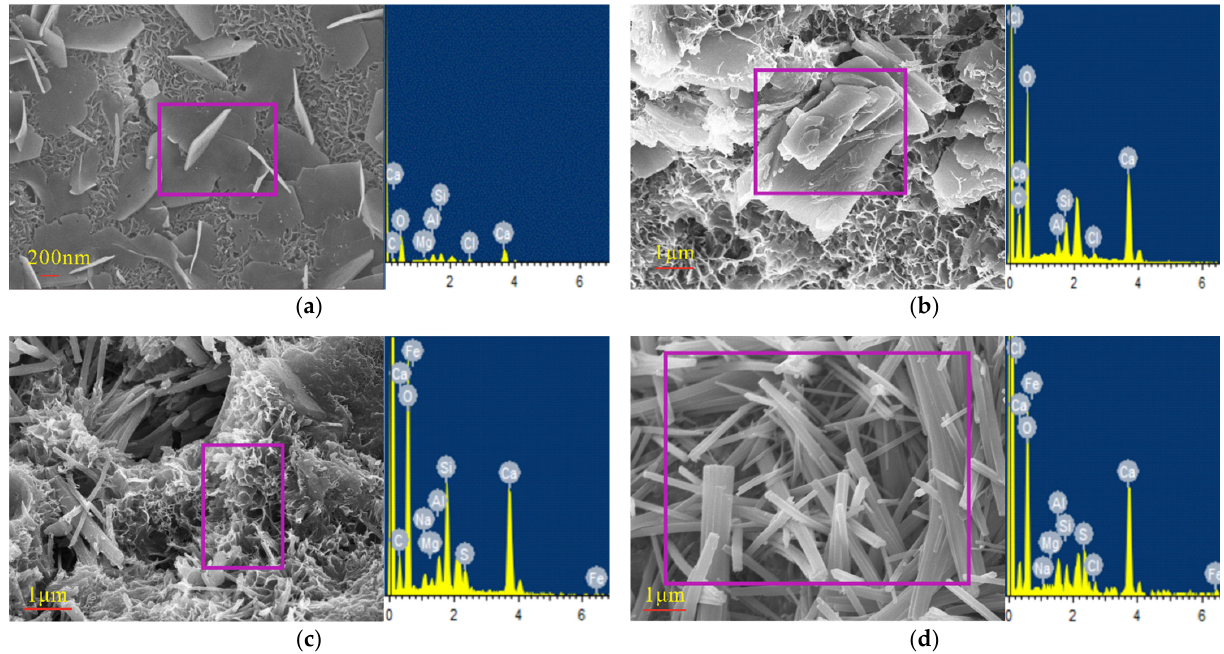
Figure 9. SEM images and corresponding EDS results of specimen ( a , b ): without sodium sulfate; ( c , d ): with 10% mixed sodium sulfate.